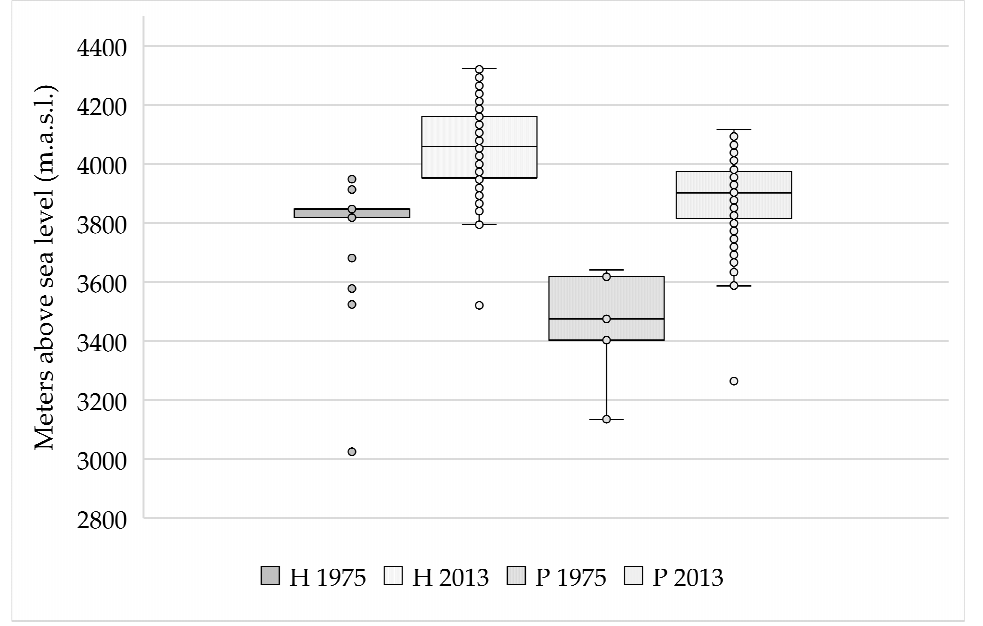
Figure 7. Altitudinal distribution of floury landraces (1975–2013) in m.a.s.l. (H = Huancavelica, P = Pasco).